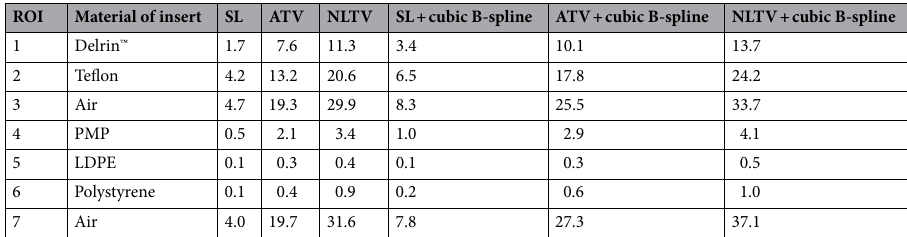
Table 2. Comparison of CNRs at seven ROIs in the low resolution reconstructed image generated by six FDK algorithms with low-dose projection data of the Catphan503 phantom.